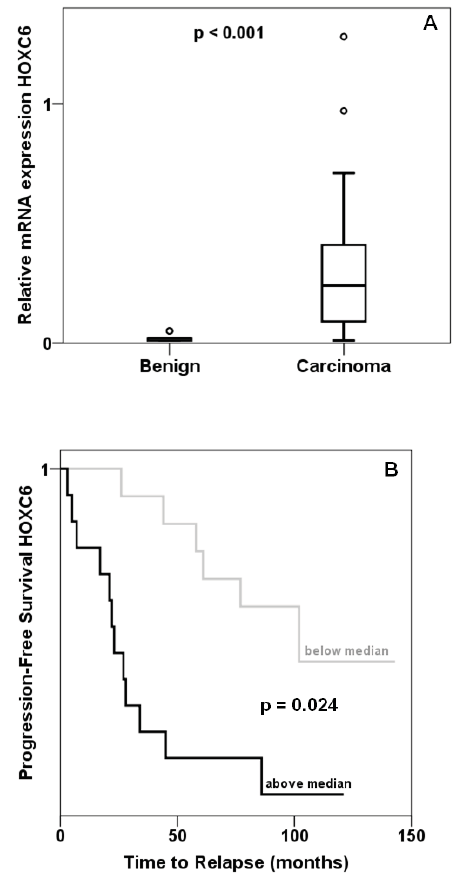
Figure 1. Expression of HOXC6 in prostate cancer. ( A ) Expression of HOXC6 mRNA as measured by quantitative RT-PCR in 45 prostate carcinoma and 13 benign prostate tissues; ( B ) Kaplan-Meier analysis of effect of HOXC6 expression on biochemical